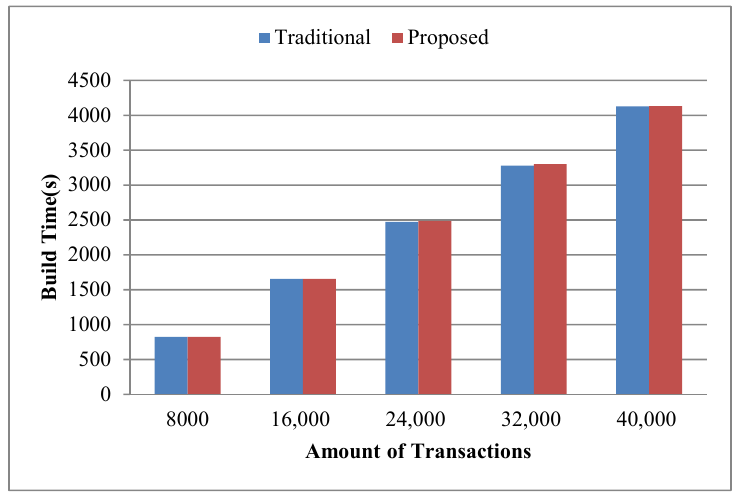
Figure 6. Build time with different amount of transactions.